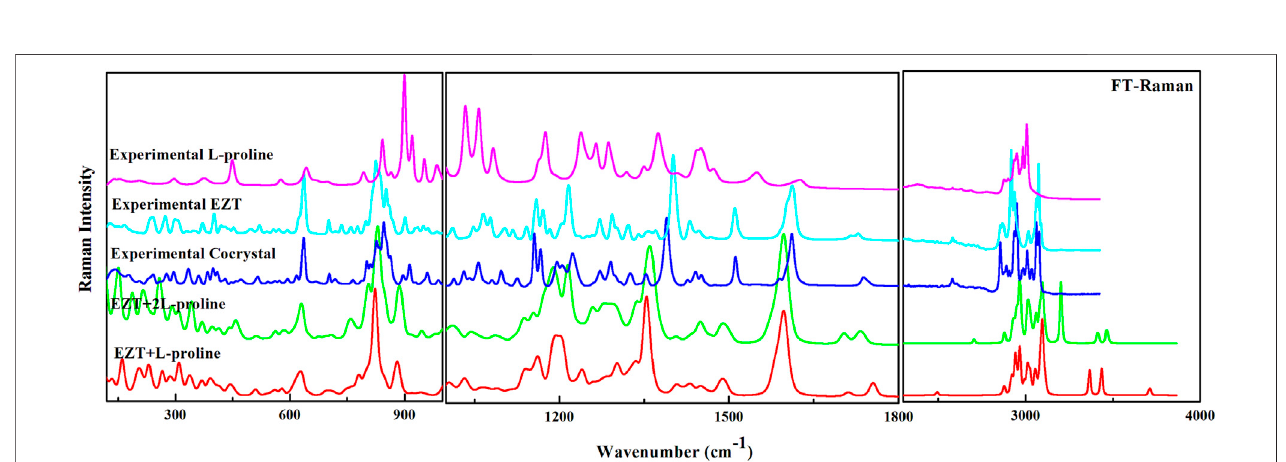
FIGURE 4 | Experimental FT-Raman spectra of EZT- L -proline, EZT, and L -proline with calculated Raman spectra of the cocrystal (EZT + L-proline and EZT + 2L- proline) in the regions 400 – 1,000, 1,000 – 2,000, and 2,200 – 4,000 cm − 1 .